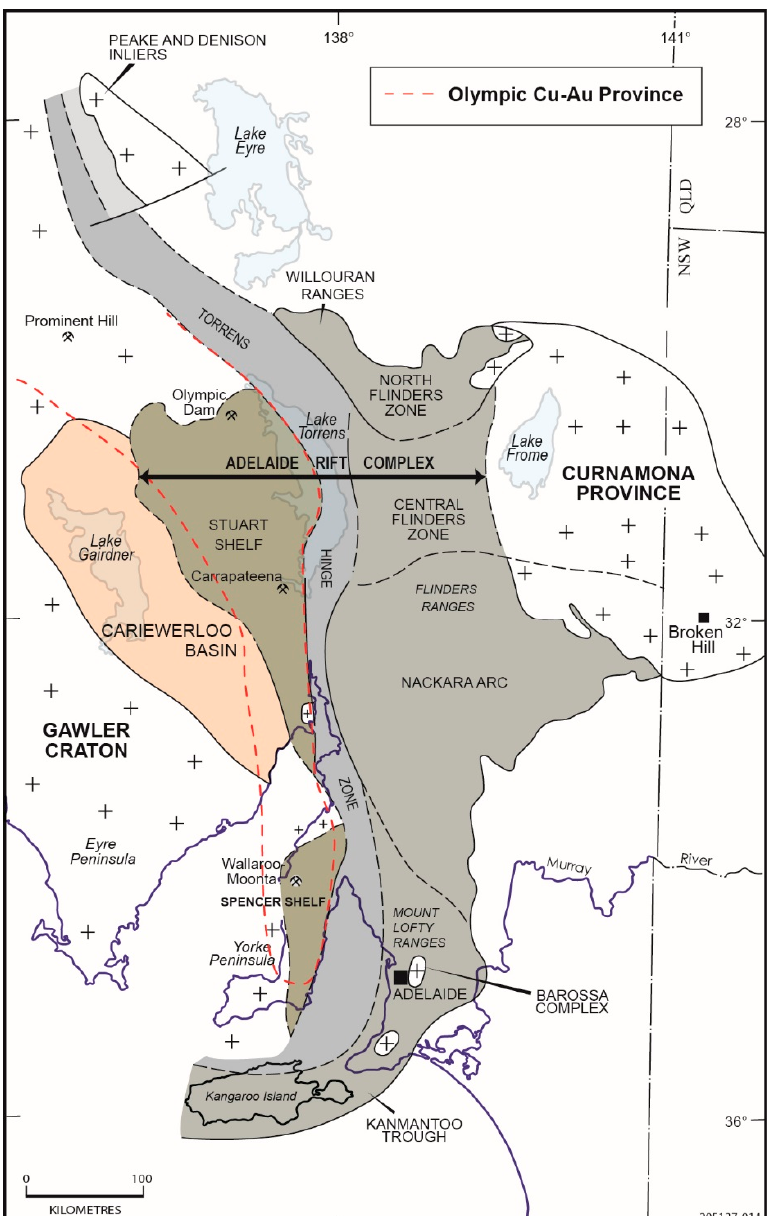
Figure 3. Location of the Carriwerloo Basin, Stuart Shelf and the subdivisions of the Adelaide Rift Complex with respect to the Gawler Craton and Curnamona Province.